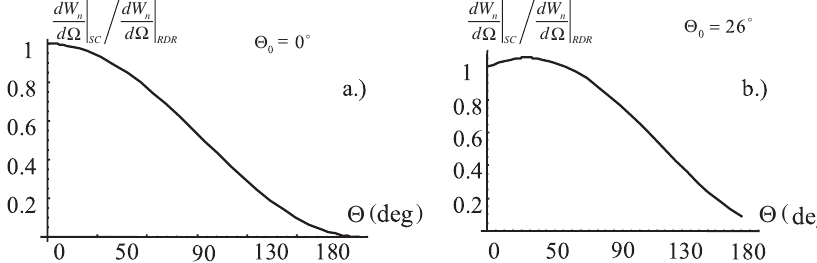
FIG. 3. Ratio between the SPR intensities for the surface current and RDR models in the relativistic case ( (cid:2) (cid:1) 1 ).